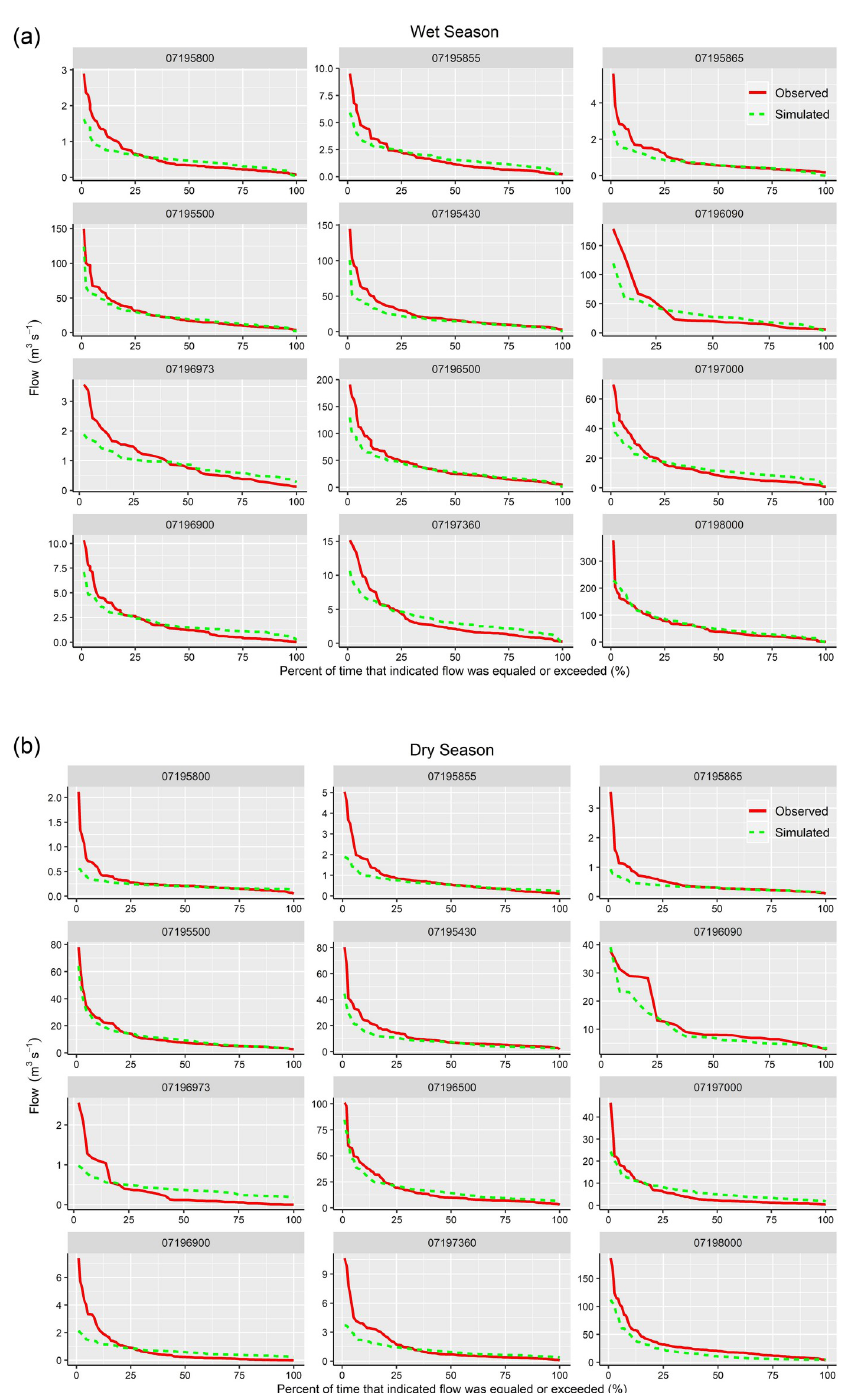
Fig 7. Flow duration curves of observed versus simulated monthly streamflow during the wet and dry season with the SWAT-SVR model.